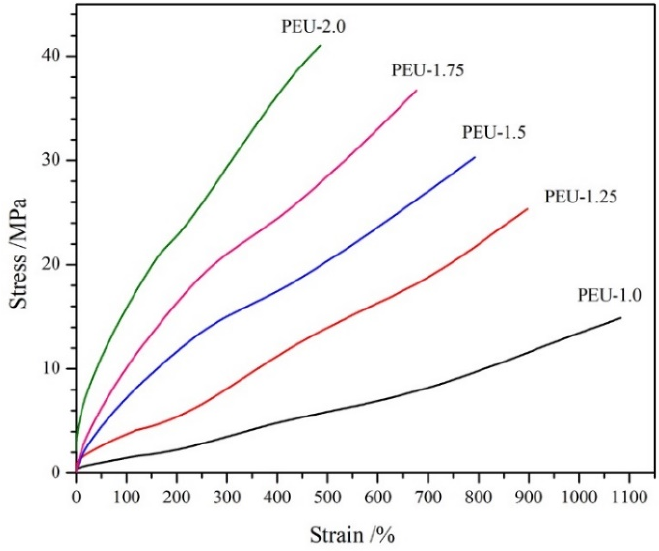
Figure 6. Representative stress ‐ strain curves for PEU films. Table 2. Tensile characteristic values for PEU films ( n = 5).